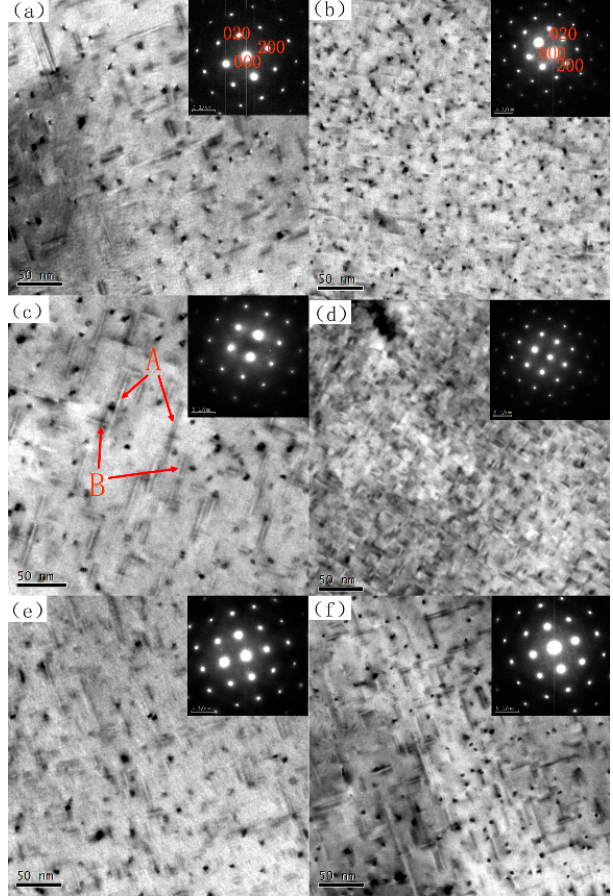
Figure 12. Images with the corresponding SADPs of N + A and P + N + A specimens. ( a )( c )( d ) N + A; ( b )( d )( f ) P + N + A; and stored in RT for ( a )( b ) 1 h; ( c )( d ) 12 h; ( e )( f ) 48 h.